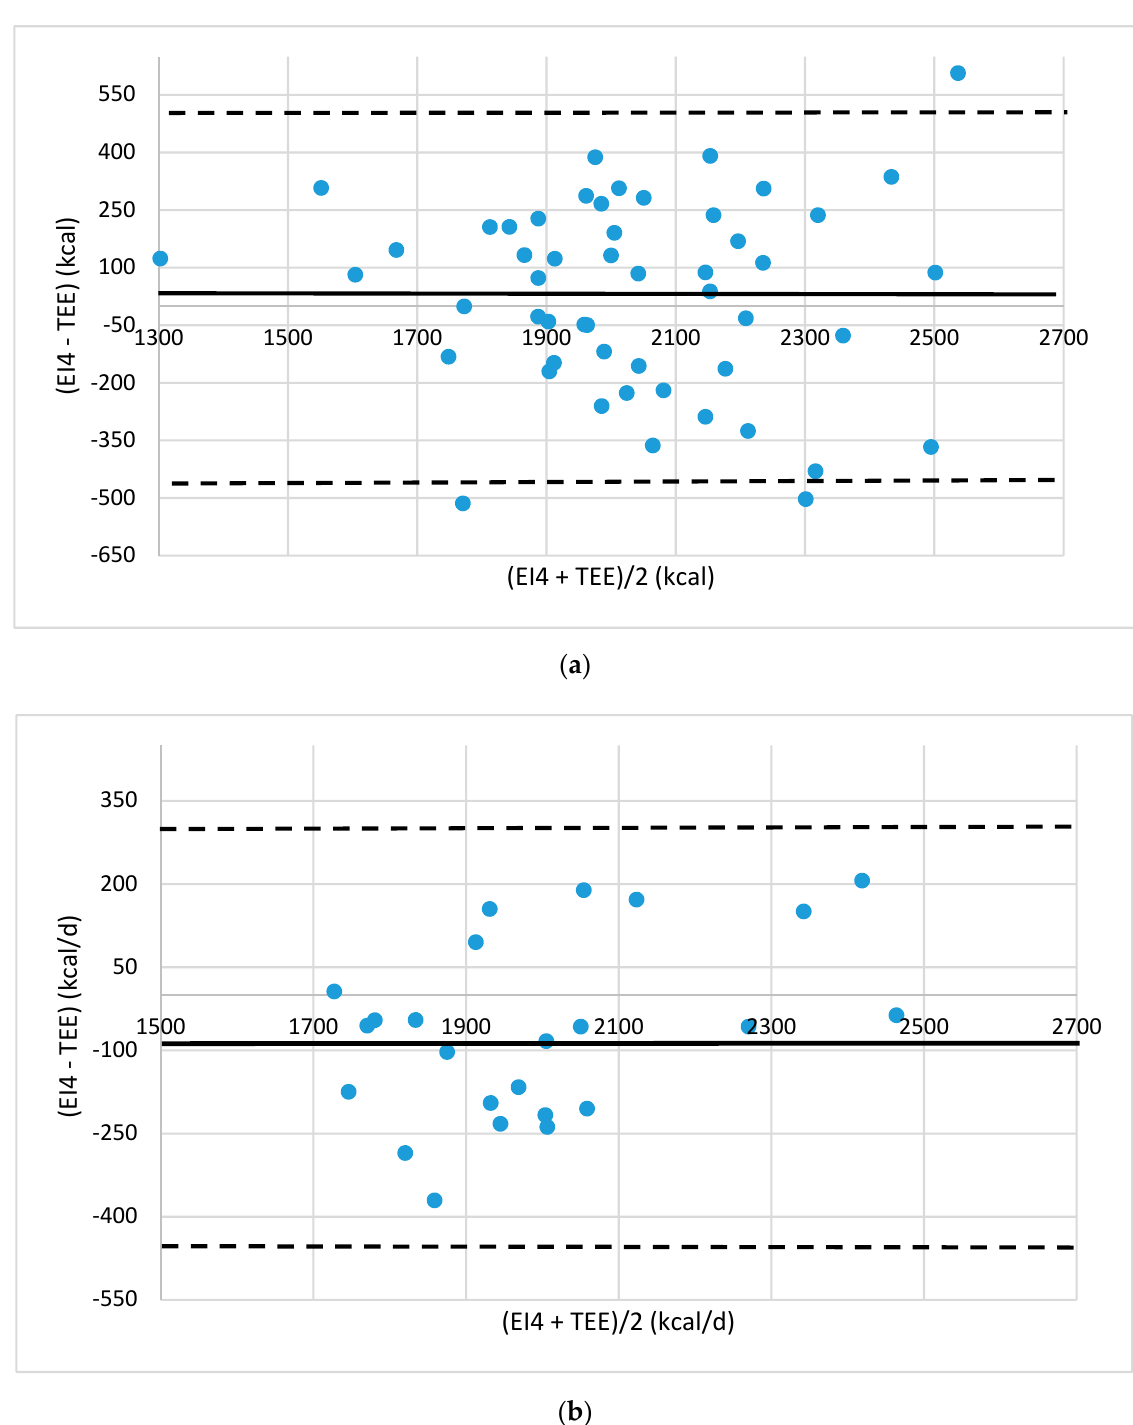
Figure 4. Bland–Altman plots of the agreement level between total energy expenditure (TEE) measured by eMouve, and energy intake (EI4) estimated by NutriQuantic in normal-weight women ( a ) in the train group and ( b ) in the test group. Bias is represented as mean difference (two standard deviations).